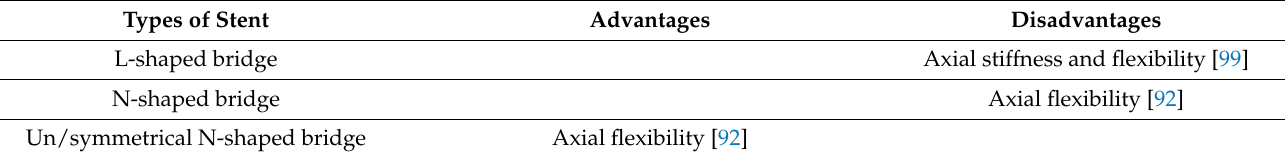
Table A1. Comparison of the Advantages of Vascular